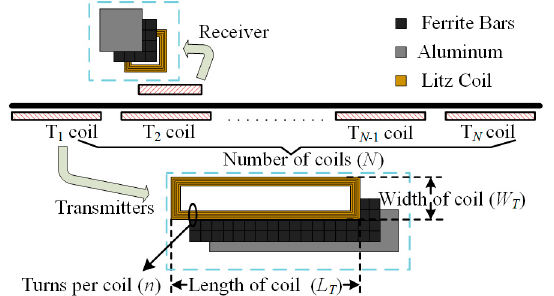
Figure 3. Diagram of a short segmented DWPT system.